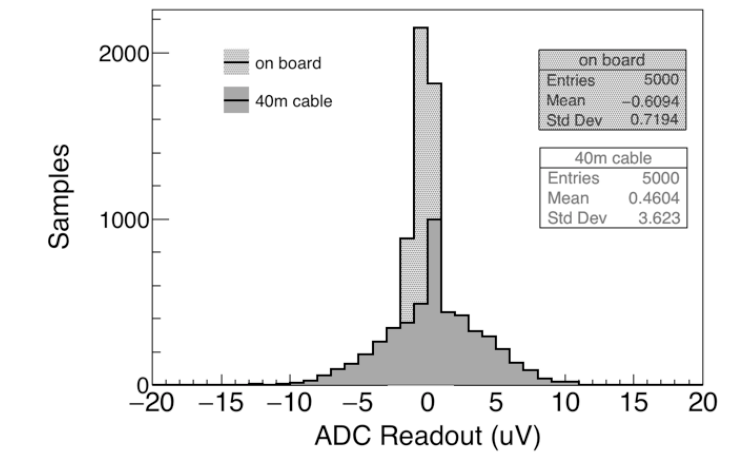
Figure 3. Common Mode at 1.1 V input with and without 40 m length cable.